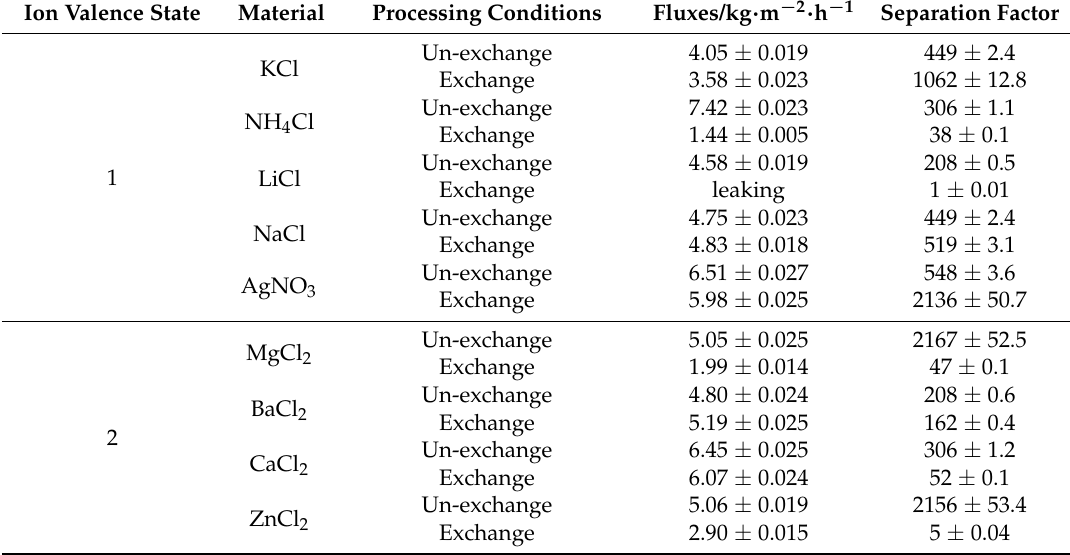
Table 1. Pervaporation of 90 wt % ethanol/water mixture through NaA-type zeolite membrane and